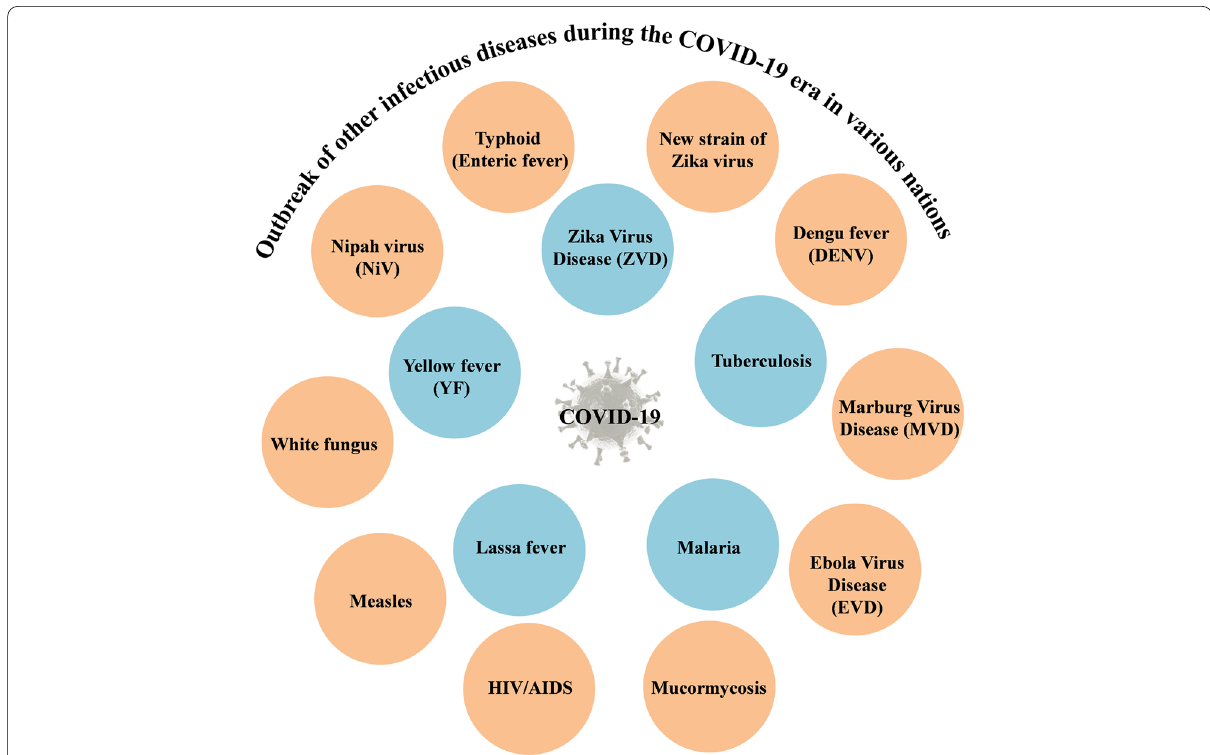
Fig. 7 Different characteristic viral diseases outburst during COVID-19 such as Zika, TB, Malaria, Lassa fever, Yellow fever, Nipah, Typhoid, new African’s strain of Zika, Dengue, Marburg, Ebola, Mucormycosis, HIV, Measles and White fungus